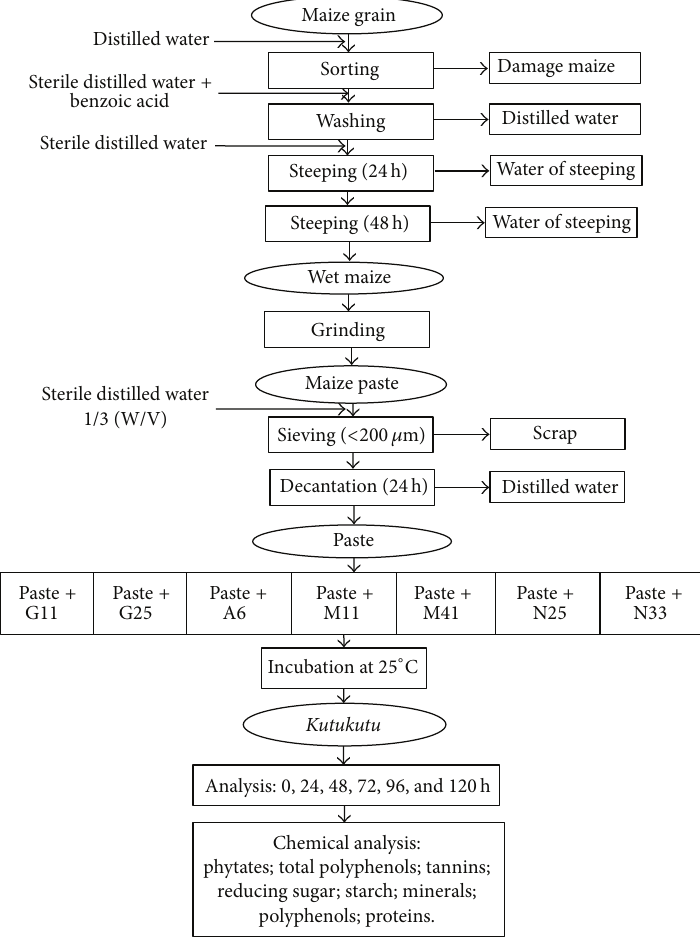
Figure 1: Diagram of inoculation of Kutukutu with LAB (G11 = L. brevis G11; G25 = L. brevis G25; A6 = L. plantarum A6; M11 = L. buchneri M1; M41 = L. cellobiosus M41; L. fermentum N33; L. fermentum